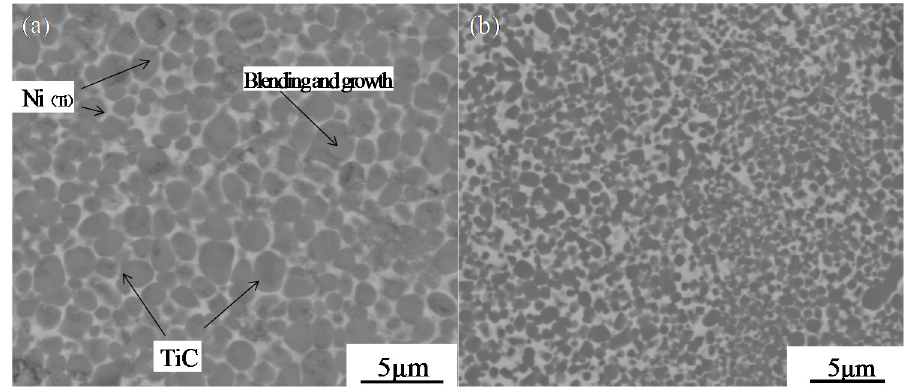
Figure 4. Microstructure of ( a ) surface layer and ( b ) interlayer.